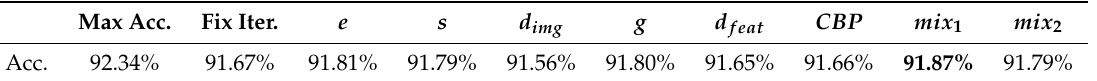
Table 1. Accuracy (Acc.) on the MNIST test set obtained stopping the training with different strategies (the experiments were repeated 20 times and the accuracies were averaged). Max Acc.